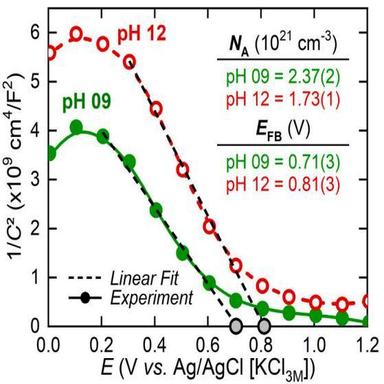
Mott-Schottky (MS) plots of the Cu2O thin films electrodeposited at pH 9 and pH 12 at the temperature of 65 ◦C. The obtained parameters NA (carrier density) and EFB (flat band potential) after a linear fit of the MS plot are also presented. The measurements were performed at room temperature (~300 K).